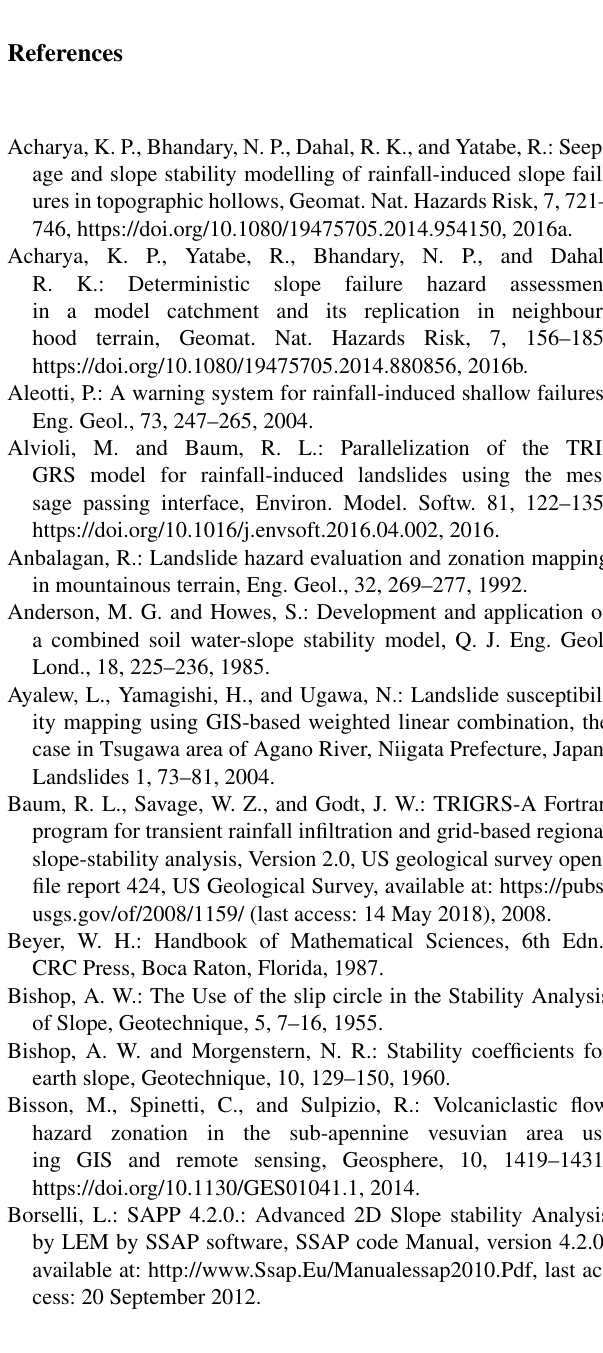
Figure 13. A new calculation including the pore coefficient r u , showing the worst curve in green. The circles show the houses dragged by the